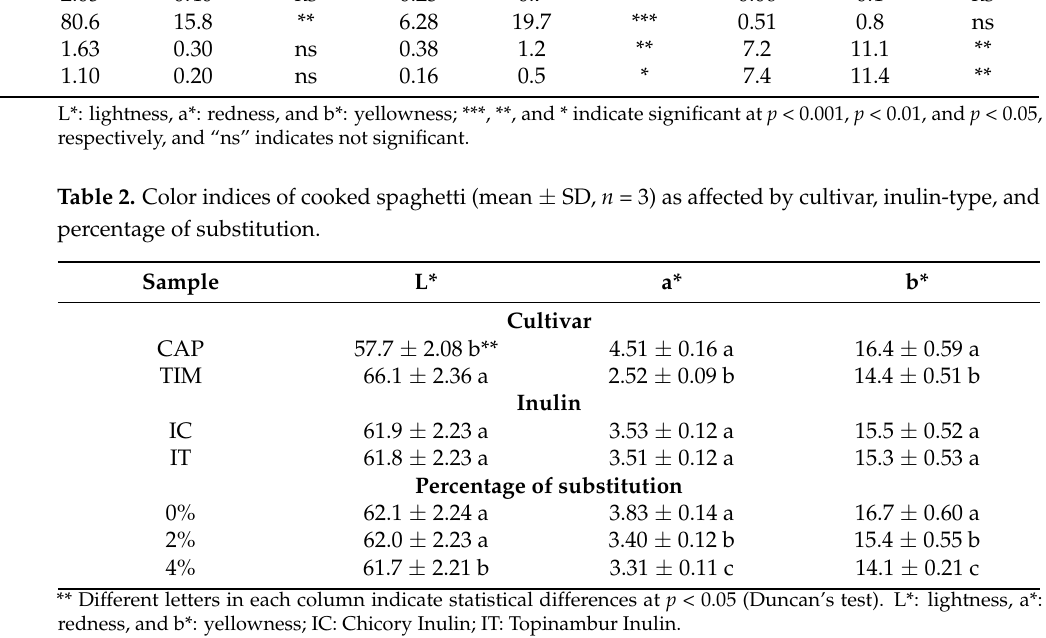
Table 3, as a percentage of variation vs. their relative CTRL. When averaged for used cultivars, both the CTRLs had all the scores for all the parameters higher than 5,